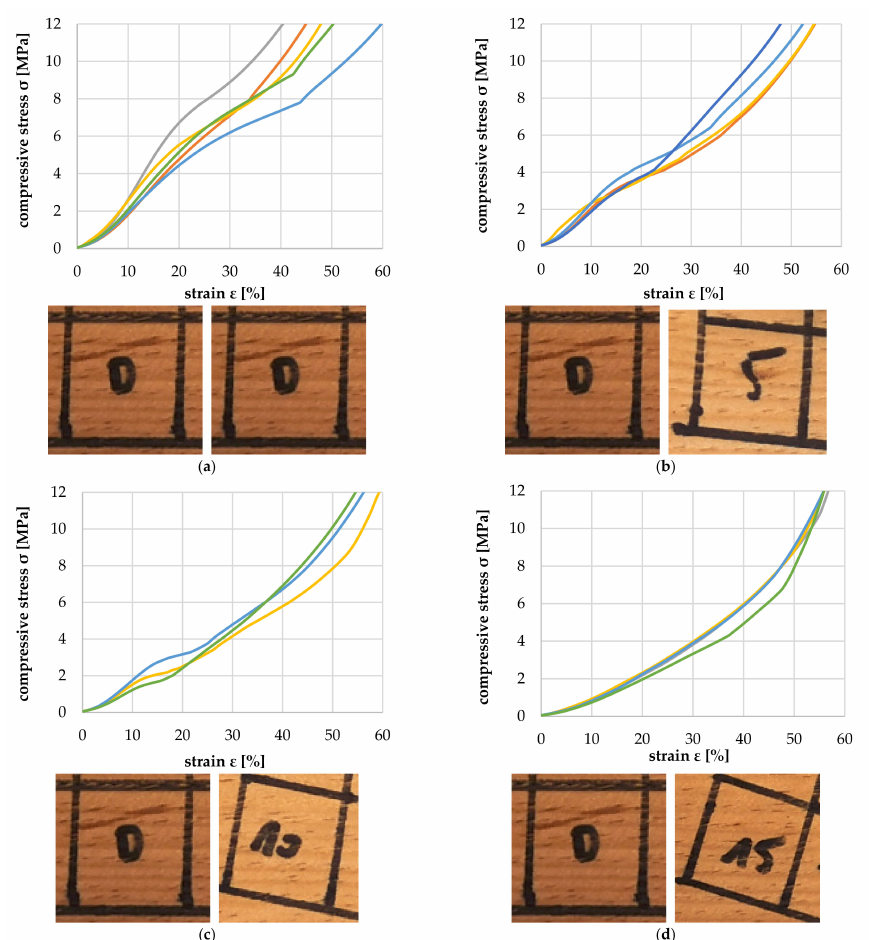
Figure 22. Compressive test with 0 ◦ ( a ), 5 ◦ ( b ), 10 ◦ ( c ) and 15 ◦ ( d ) deviation in the longitudinal